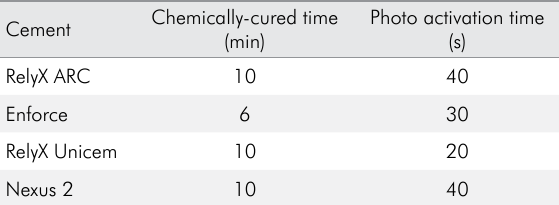
Table 2. Activation modes for each resin cement.